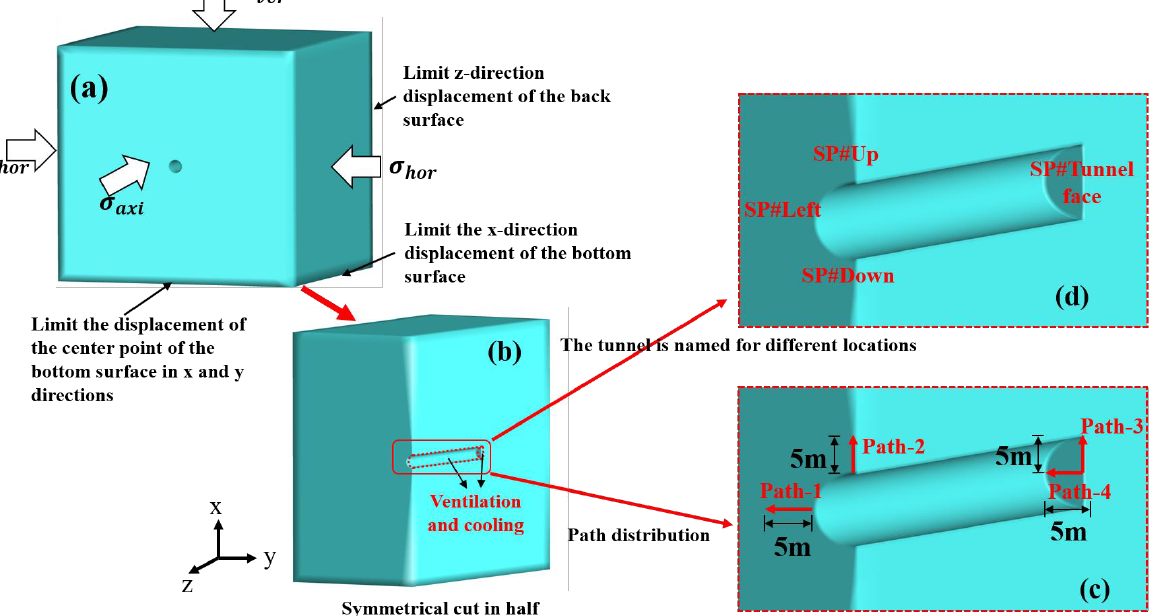
Figure 5. Schematic diagram of the model and boundary conditions. ( a ) The setting of mechanical boundary conditions. ( b ) The setting of temperature boundary conditions. ( c ) The length and distribution of four different paths. ( d ) The names of the different locations of the tunnels.